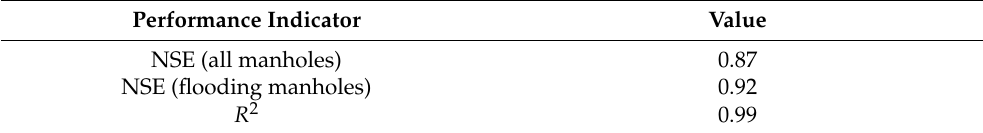
Table 2. The hyper-parameter and evaluation values of the LSTM sequential model after Bayesian op-